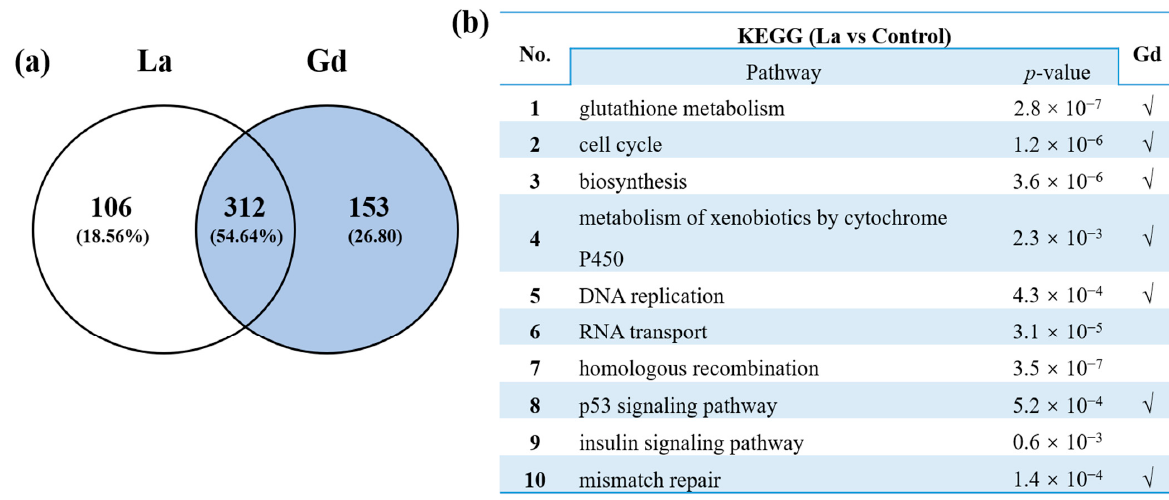
Figure 3. Analysis of the shared differentially expressed genes between La and Gd: ( a ) Venn diagrams showing the differentially expressed genes shared in response to La and Gd exposure; ( b ) top 10 significantly enriched KEGG pathways shared in response to La exposure. √ Indicates the pathways involved in Gd exposure.